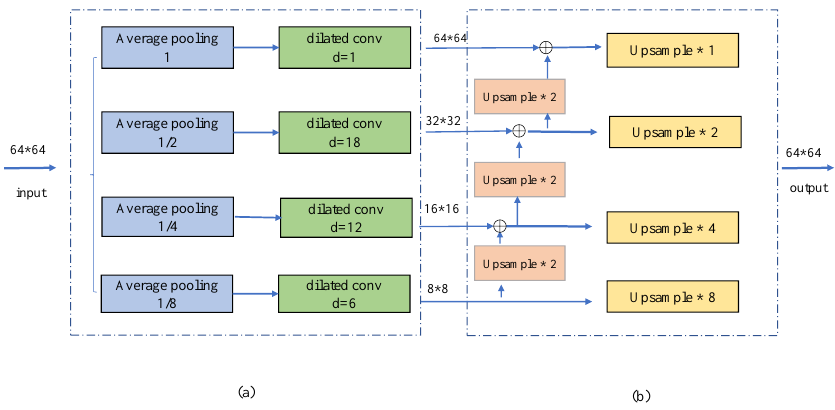
Figure 3. Widely Adapted Spatial Pyramid (WASP). ( a ) The Multi-Scale Feature Extraction. ( b ) The Progressive Upsample structure. “d” respresents the dilated rate of